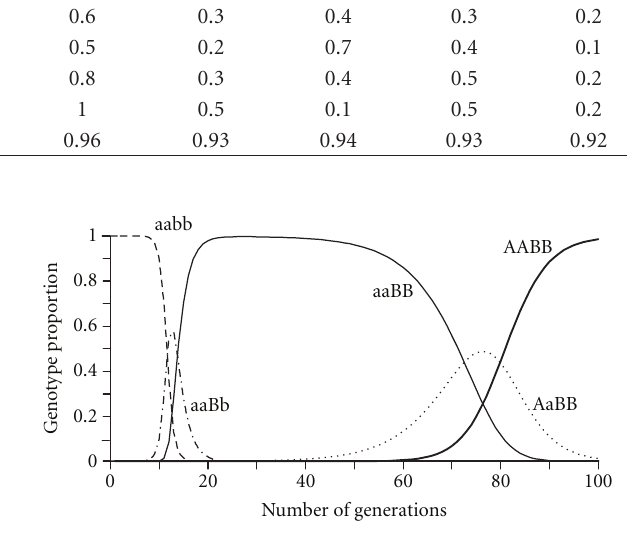
Figure 2: Change in proportions of the nine genotypes during 100 generations (example 2) with indiscriminate mating in which there were initially about 10 7 (0.9999998 aabb) individuals and initially one mutation of a to A (0.0000001 Aabb) and one of b to B (0.0000001 aaBb) resulting in 0.986431 AABB (four genotypes never achieved any significant proportion). Relative survival of each genotype was S 1 = 1 (AABB), S 2 = 0.6 (AABb), S 3 = 0.3 (AAbb), S 4 = 0.8 (AaBB), S 5 = 0.5 (AaBb), S 6 = 0.2 (Aabb), S 7 = 0.7 (aaBB), S 8 = 0.4 (aaBb), and S 9 = 0.1